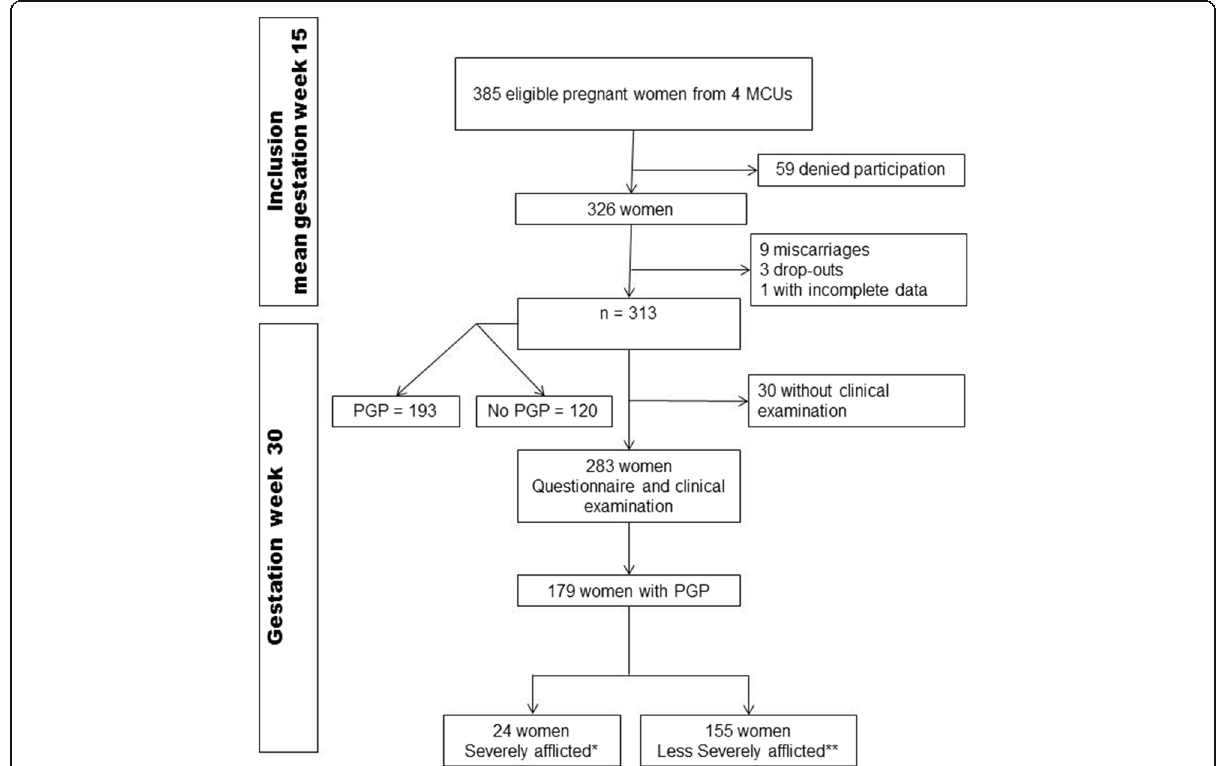
Fig. 1 Flow chart. *Severely afflicted women ( “ Severe PGP ” ) have. 1) Combined pain in symphysis and bilateral posterior pain, AND. 2) Bilateral positive P4 test, AND. 3) ASLR score on 4 or more. **Less severely afflicted women ( “ Less severe PGP ” ) have one or two of the 1),2), 3)